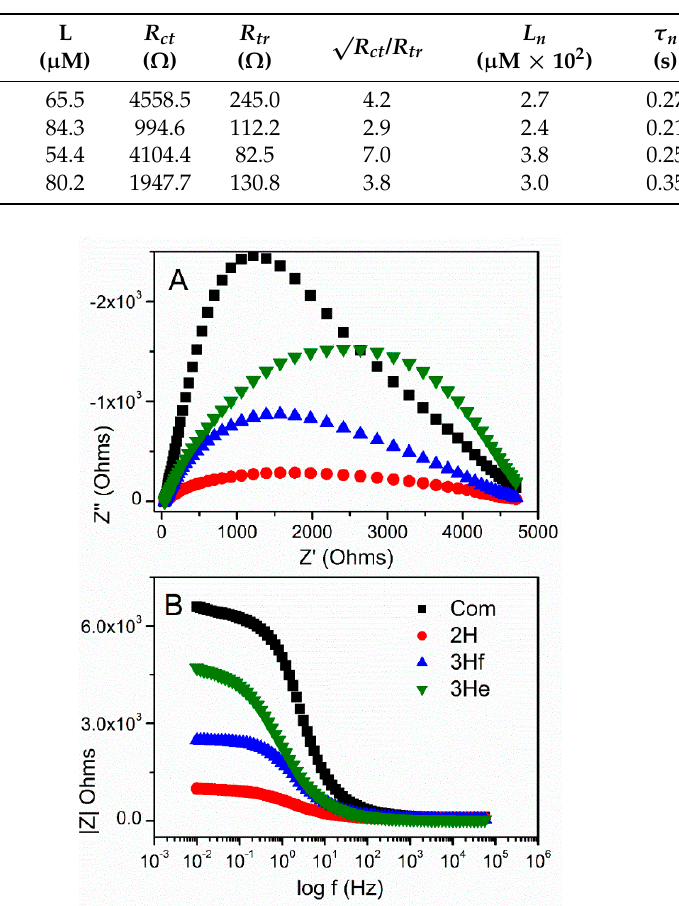
Figure 8. Nyquist plots ( A ) and Bode diagrams ( B ) under illumination for commercial ZnO (black) and ZnO synthesized by bipolar electrochemistry.